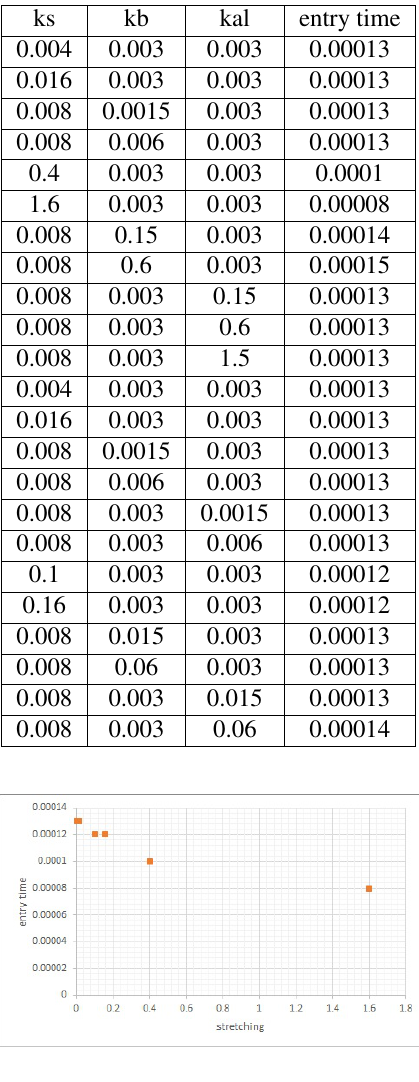
Fig. 4. Dependency of entry time on stretching parameter.